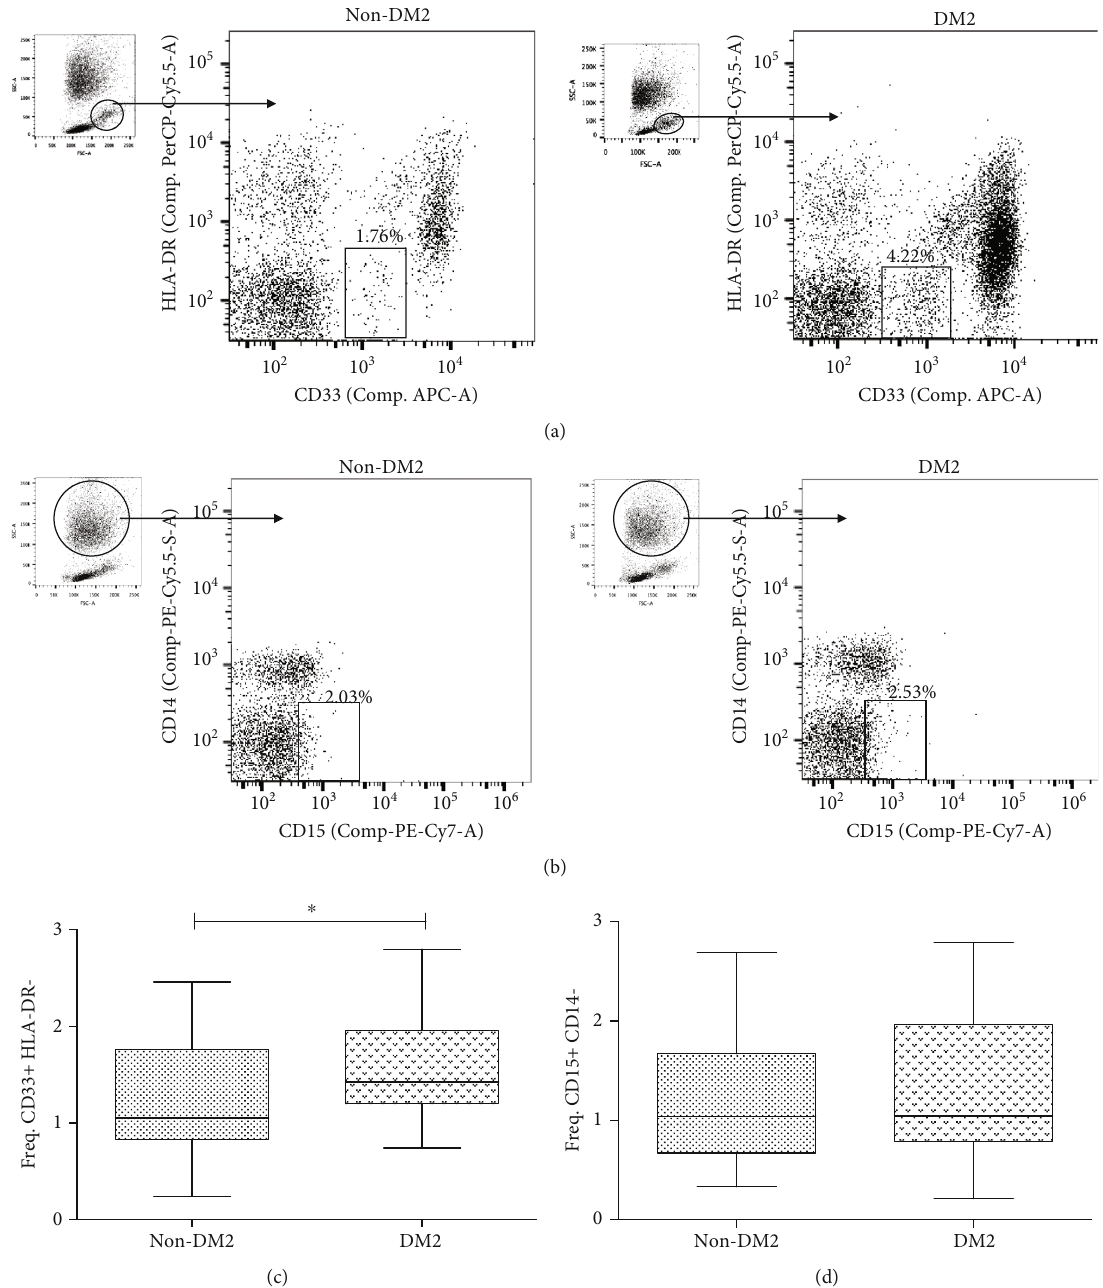
Figure 1: Gating strategy and frequencies of MDSCs in DM2. (a) Dotplot APC vs. PerCP-Cy5.5 shows PBMCs and the gate mark of the CD33+ HLA-DR-/low MDSCs. (b) Dotplot PE-Cy7 vs. PE-Cy5 shows PBMCs and PMNs and the gate mark of the CD15+ CD14- MDSCs. (c) Frequency of CD33+ HLA-DR-/low MDSCs, comparing the group of DM2 ( n = 22 ) with the non-DM2 group ( n = 21 ). The graph shows the median with interquartile ranges. (d) Frequency of CD15+ CD14- MDSCs, comparing the group of DM2 ( n = 20 ) with the non-DM2 group ( n = 21 ). The graph shows the mean and standard deviation. A P value < 0.05 was considered as statistically signi fi cant which was calculated using the statistical test of Mann-Whitney. Statistical analysis was performed with the GraphPad Prism® v5.0 software. Data were obtained in a BD FACSCanto II® Flow Cytometer and were analyzed with the software FlowJo®